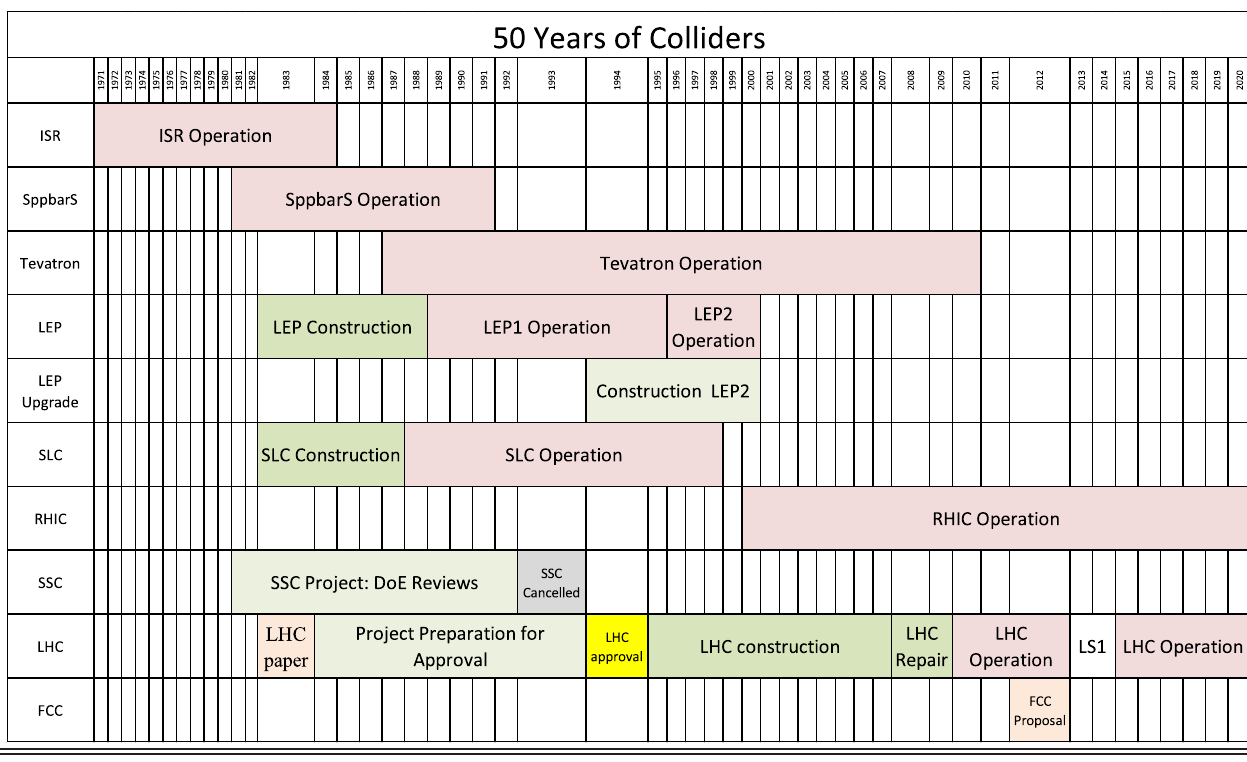
TABLE V. Chronological evolution of the world ’ s high energy colliders from 1971 to the present